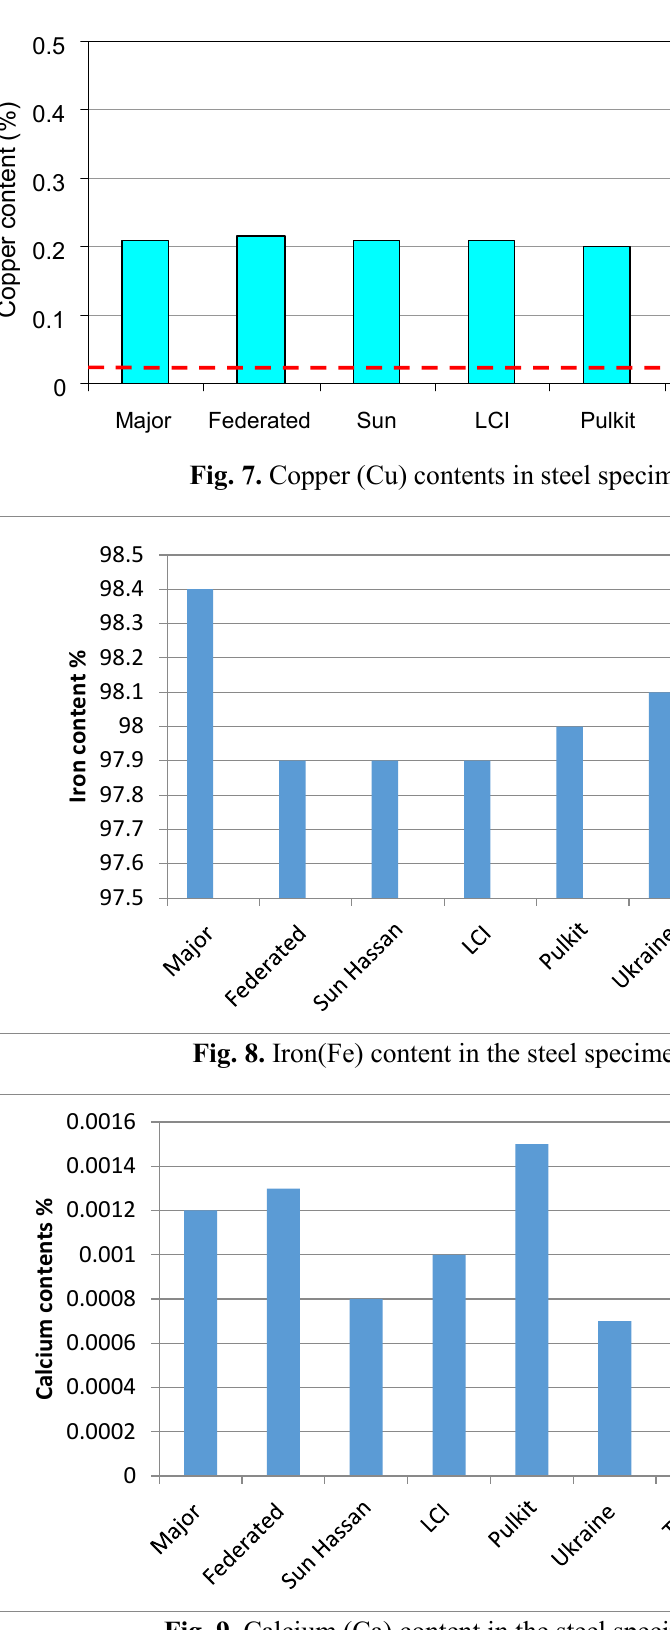
Fig. 9. Calcium (Ca) content in the steel